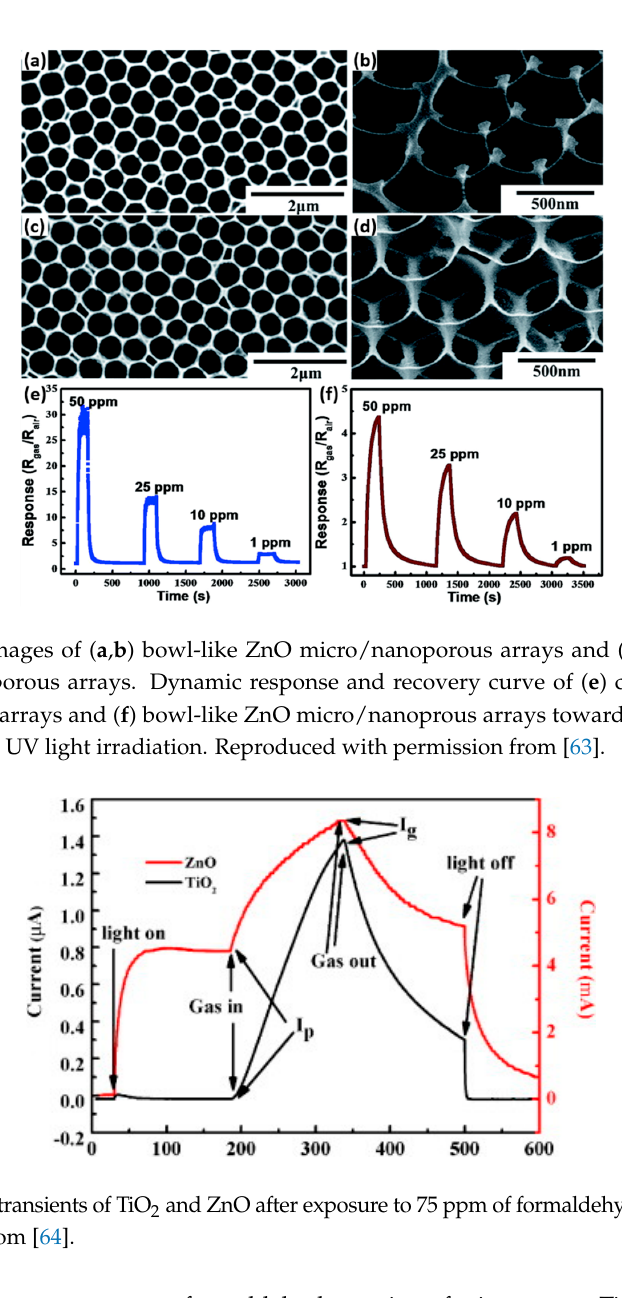
Figure 35. Schematic of surface reactions and corresponding energy barriers ( qV T and qV Z , in which q is the electron charge and V T , V Z are potential barriers of TiO 2 and ZnO, respectively) under different conditions: ( a ) in dry air and in the dark; ( b ) in dry air and with UV light illumination; ( c ) in test gas and with UV light illumination. Reproduced with permission from [64]. Liu studied the room temperature formaldehyde sensing of microporous TiO 2 (Figure 36). Instead of the commonly used D.C. resistance measurement, they used an A.C. measurement approach to obtain the impedance which was deemed more stable and with higher response. The sensing response has been defined as the normalized impedance change. They found that UV irradiation together with a certain humidity could improve the formaldehyde sensing response. However, the response decreased with further humidity increasing (Figure 37). This was due to the fact that UV irradiation led to the formation of hydroxyl group from the water adsorbed on the surface of TiO 2 and hydroxyl would react with interacted formaldehyde molecules which caused the sensing signal. However, if the concentration of water molecules was too high, sensing performance